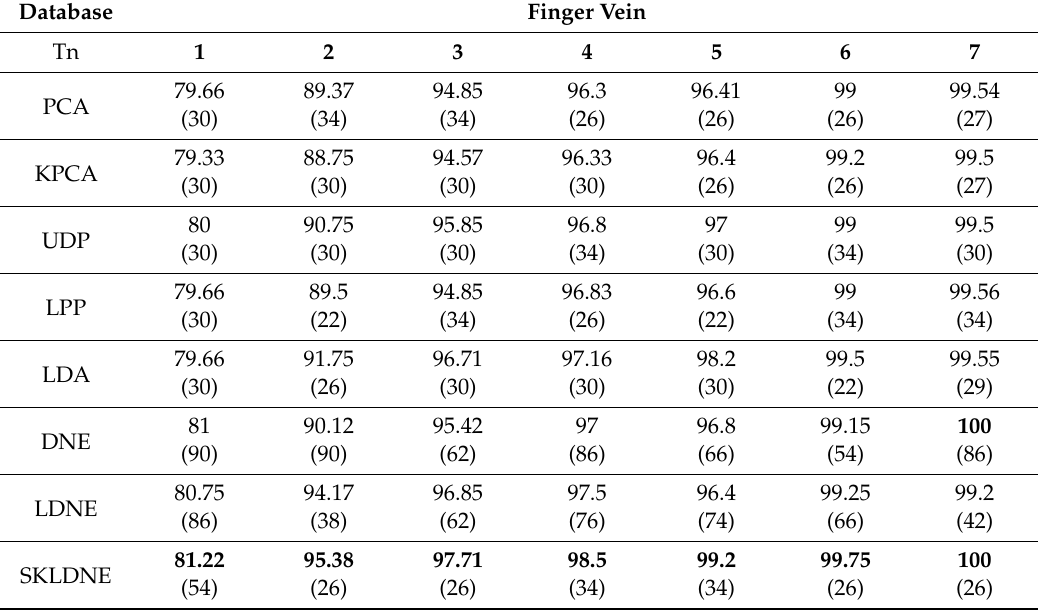
Table 5. Maximum recognition accuracies (in percentage terms) of SKLDNE and other methods for the different number of training and testing images on Finger Vein database and corresponding dimensions (shown in parentheses).